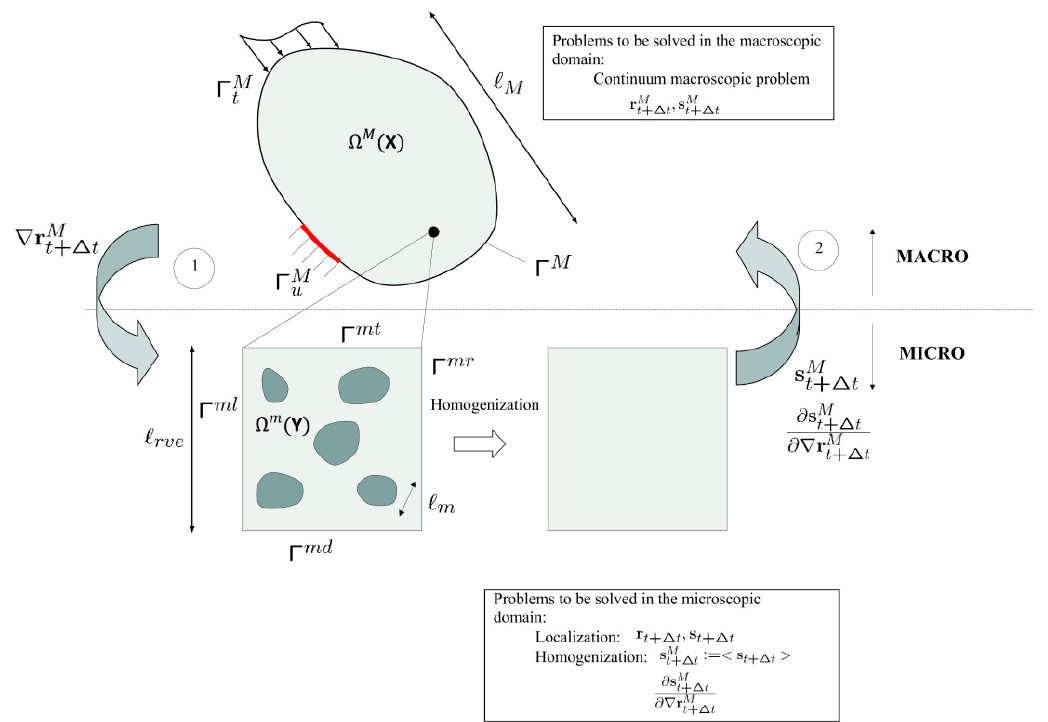
Figure 5. General multiscale procedure based on first order homogenization. Field and state variables computed at the macroscale for a given time increment are denoted as r M and s M , t + ∆ t t + ∆ t respectively. The first gradient of the field variable ∇ r M is provided to the microscopic scale. Then, t + ∆ t the localization problem is solved and the microscopic quantities r t + ∆ t and s t + ∆ t are obtained. Finally, the homogenized variable s M and the linearized material tangent operator ∂ s M / ∂ ∇ r M are t + ∆ t t + ∆ t t + ∆ t passed to the macroscopic scale. This process is repeated